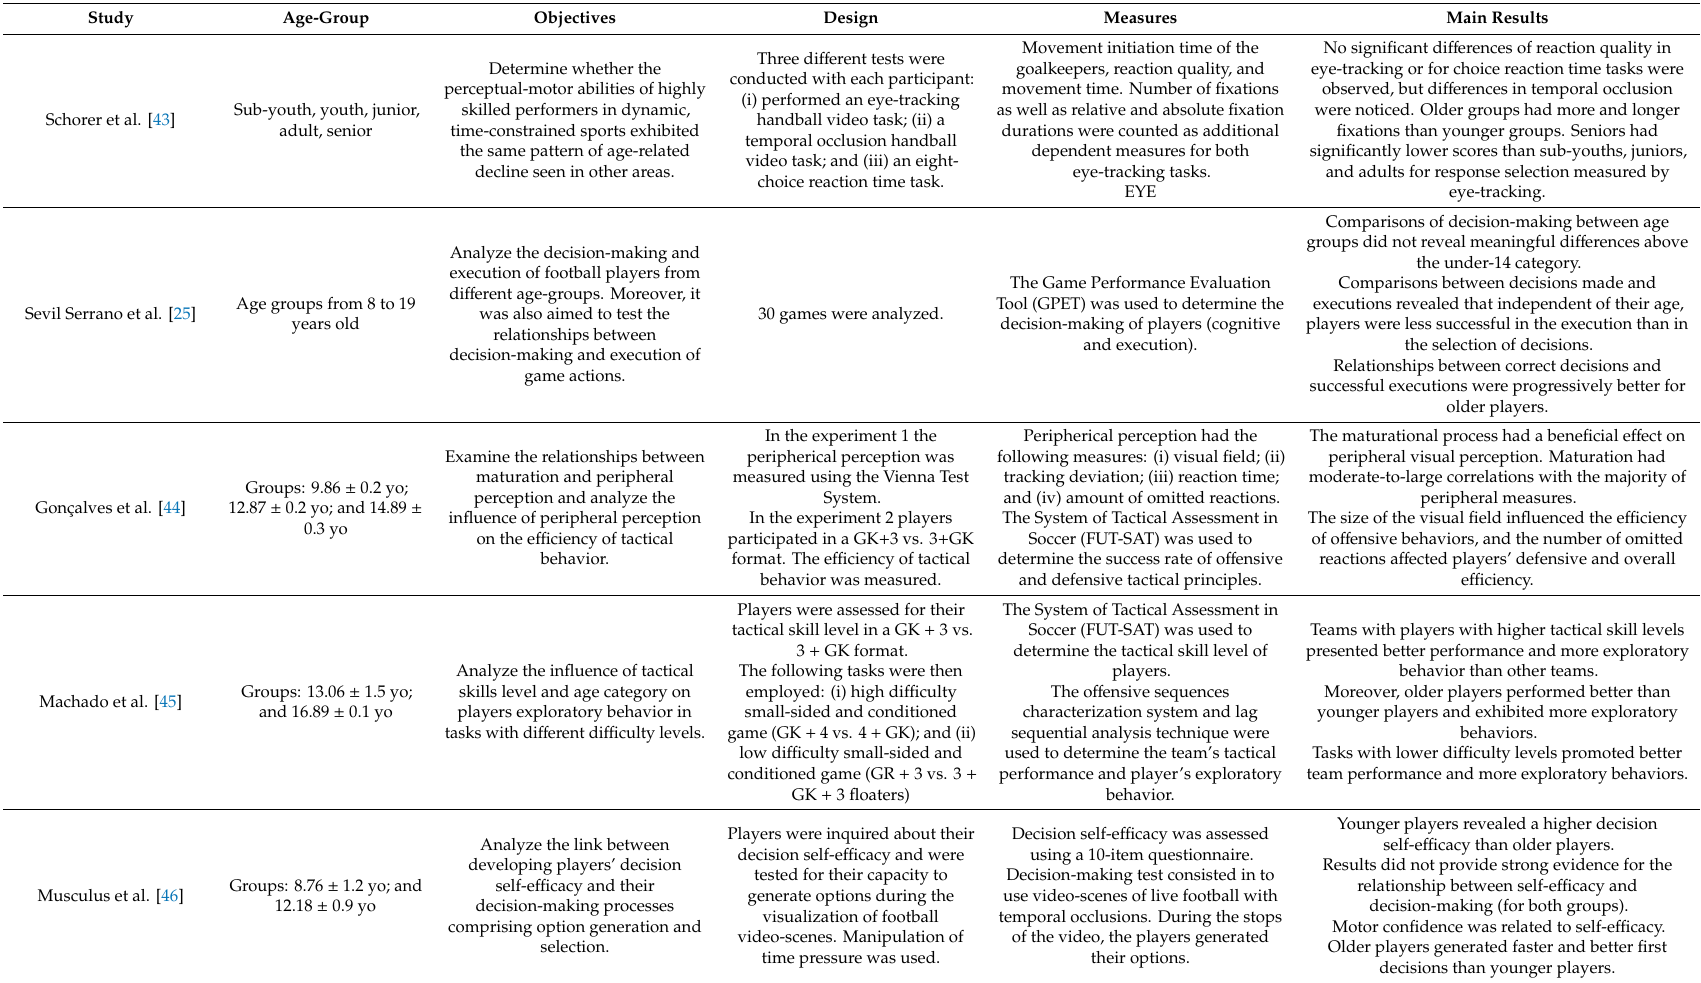
Table 3. Studies that compared the decision-making processes between di ff erent age groups in youth team-sports